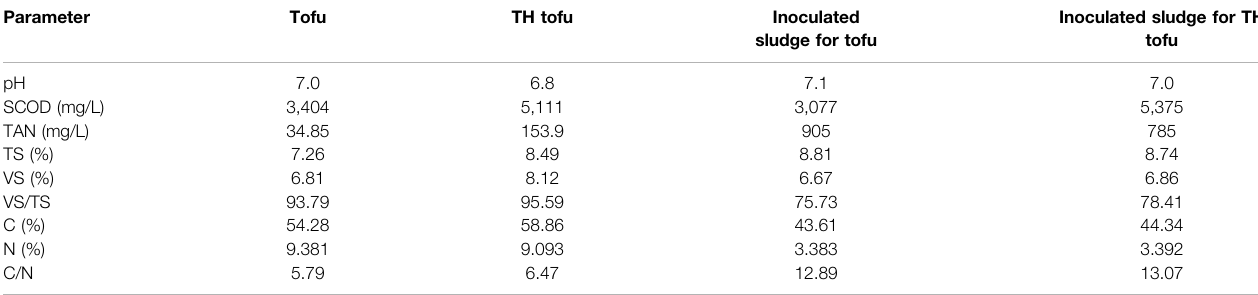
TABLE 1 | Physical and chemical properties of test materials. Parameter Tofu TH tofu Inoculated